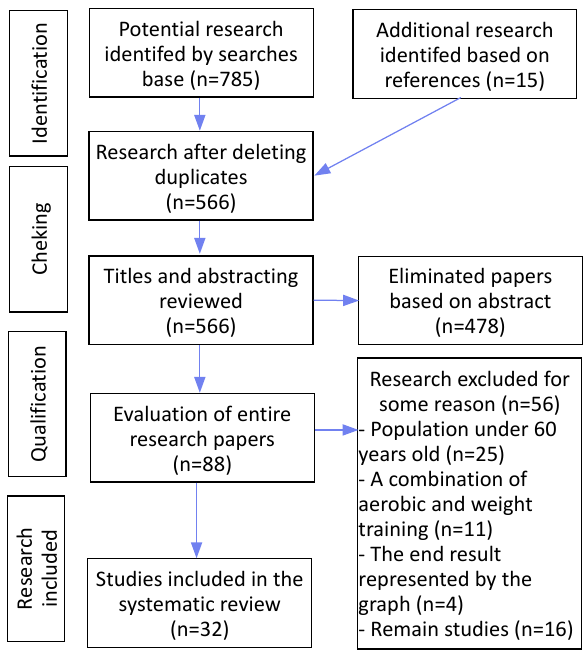
Figure 1. Flow Diagram Aerobic